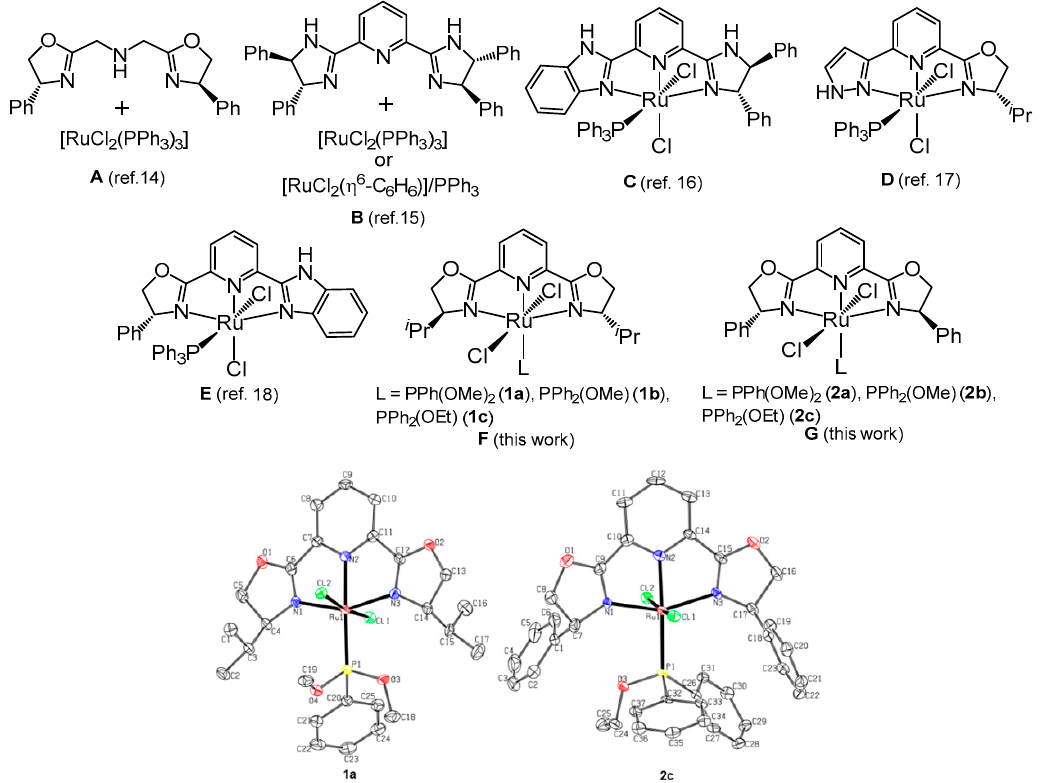
Figure 1. Selected ruthenium(II) complexes, bearing enantiopure C 2 or C 1 symmetry N , N , N -donor ligands, used in asymmetric transfer hydrogenation (ATH) of ketones (Examples corresponding to complexes A – E feature the N-H functionality; structures F – G lack the N-H functionality).